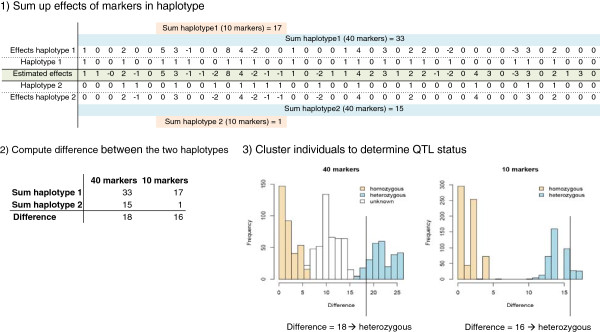
QTL status prediction.